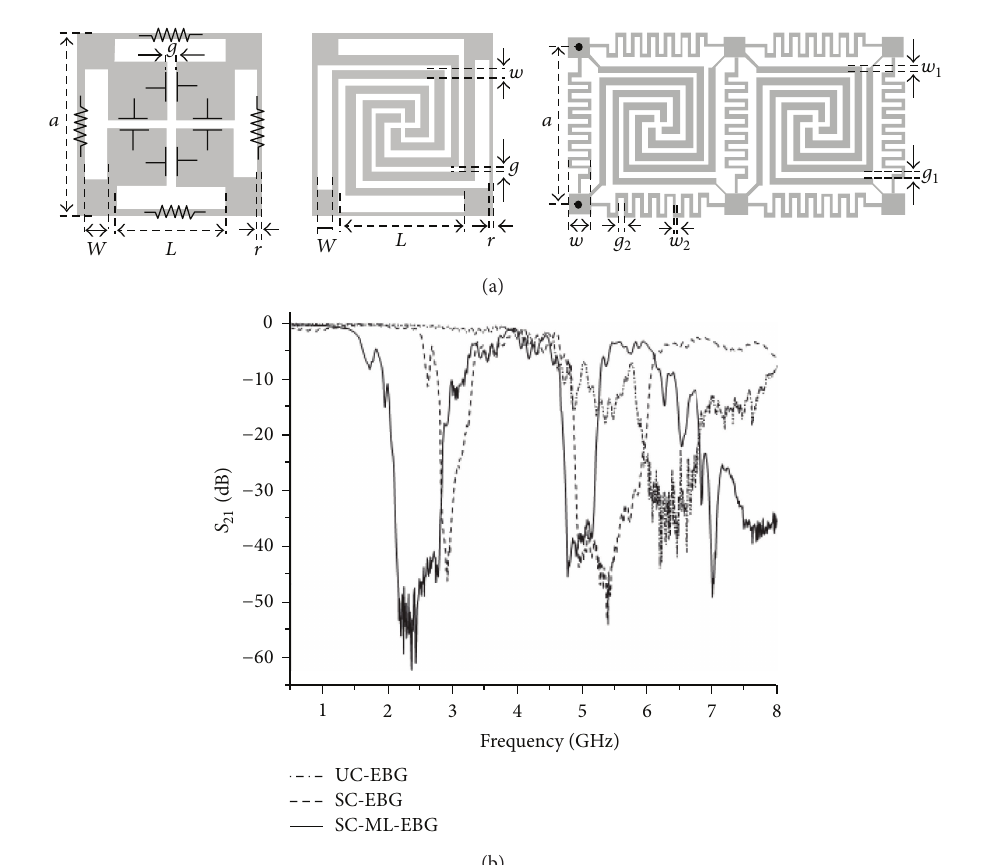
Figure 10: (a) Successive modification from a regular shape UC-EBG to SC-ML-EBG and (b) their transmission responses ( 𝑆 21 ).